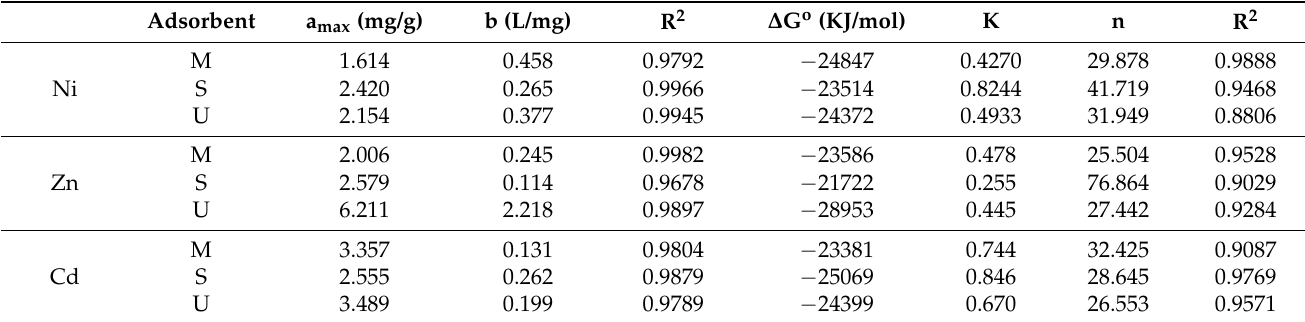
Table 3. Langmuir and Freundlich adsorption isotherm